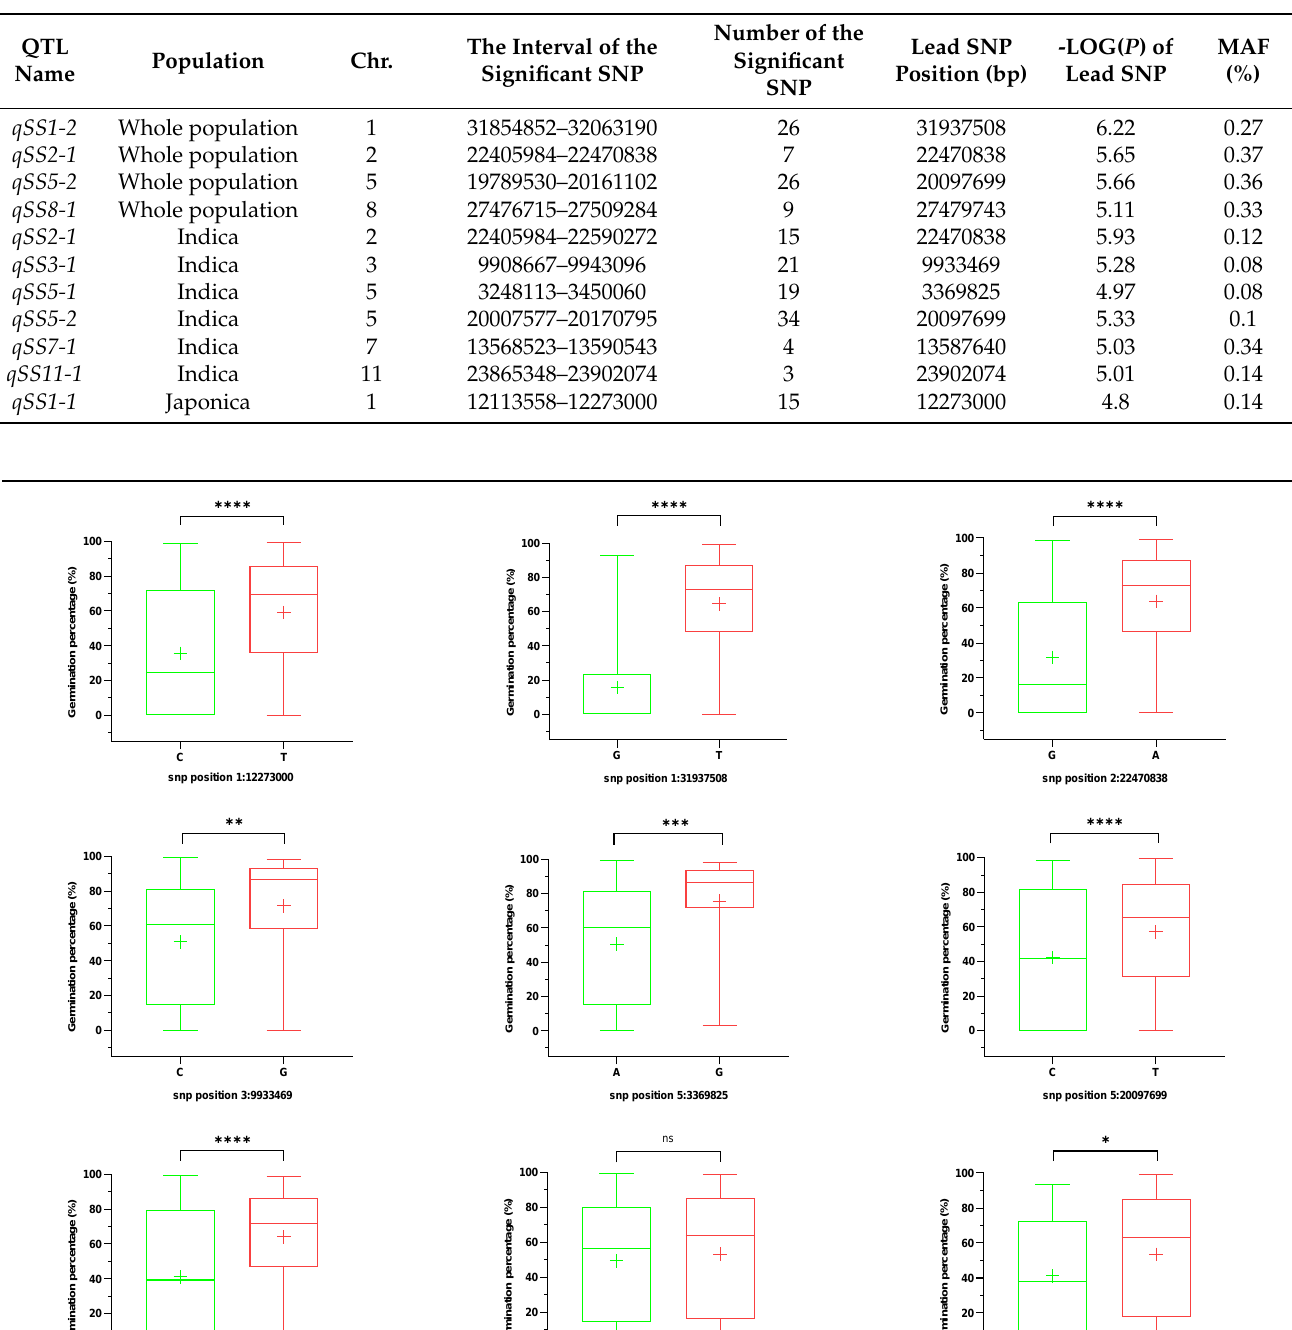
Table 1. The QTLs were detected in the whole population, indica subspecies, and japonica subspecies, respectively.